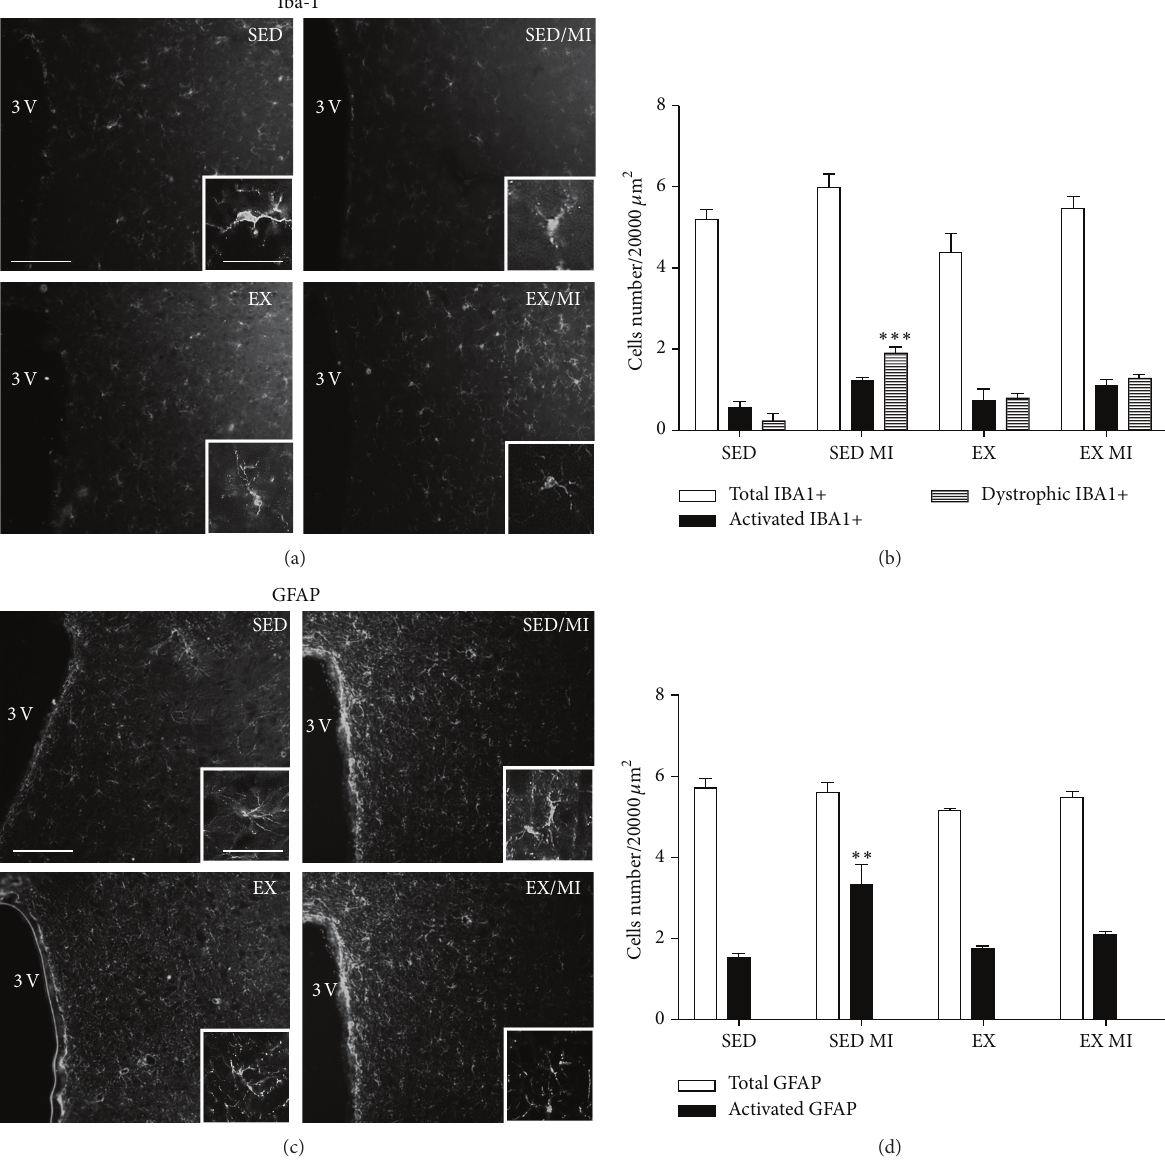
Figure 5: Effect of prolonged exercise on MI induced microglia and astrocyte morphological changes in the PVN. 48 hMI induced significant changes in the senescent ( 1.8 ± 0.1 ) (dystrophic-like) microglia in the PVN as compared to the sedentary group without MI ( 0.2 ± 0.1 ) (a, b). 48 h MI induced increased number of reactive astrocytes in the PVN ( 3.3 ± 0.51 ) versus control ( 1.5 ± 0.09 ). (c, d). Data are presented as mean ± SEM. ANOVA followed by Tukey post hoc test was used for statistical analysis. Four animals were used for each experimental group. ∗ 𝑃 < 0.05, ∗∗ 𝑃 < 0.01 , and ∗∗∗ 𝑃 < 0.001 versus sedentary group. Scale bars 100 and 25 𝜇 m for panoramic and inset image,